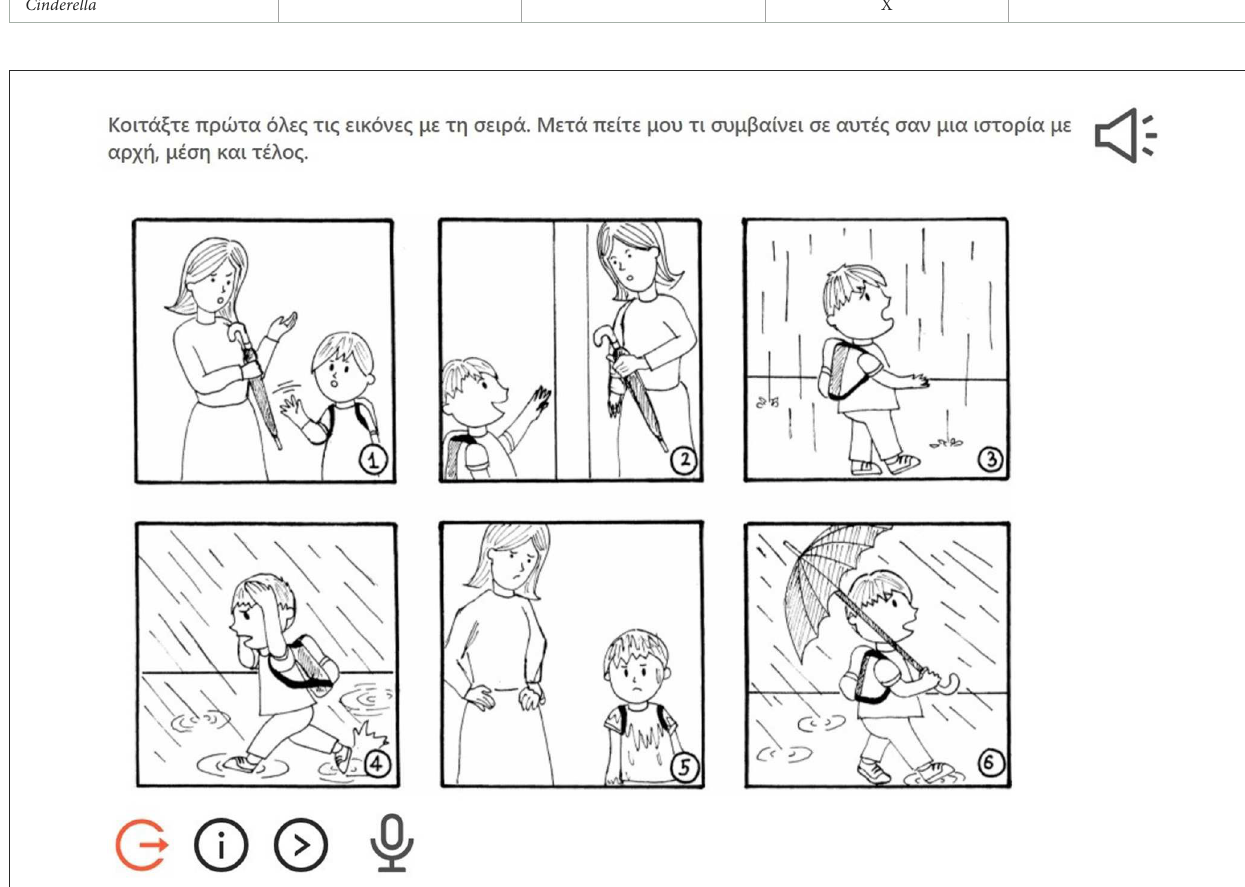
FIGURE1 Home screen of the Refused umbrella task (picture adopted from the AphasiaBank protocol, MacWhinney et al.,